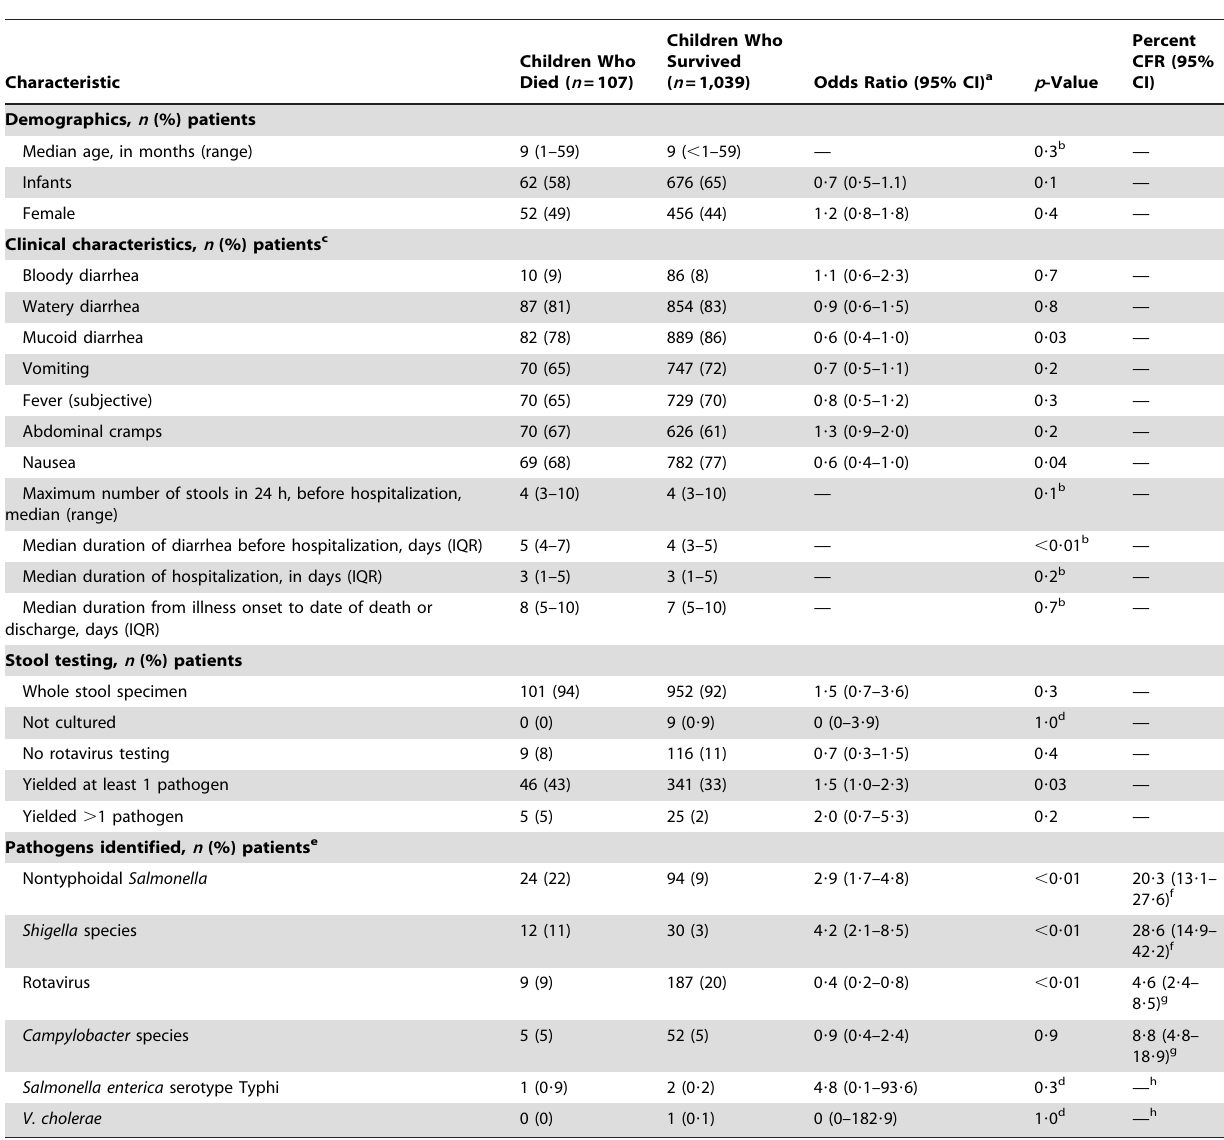
Table 2. Demographic and clinical characteristics, enteric pathogens identified, and pathogen-specific CFRs for 1,146 children , 5 y old hospitalized with diarrhea, by children who died ( n =107) and survived ( n =1,039), western Kenya 2005–2007.